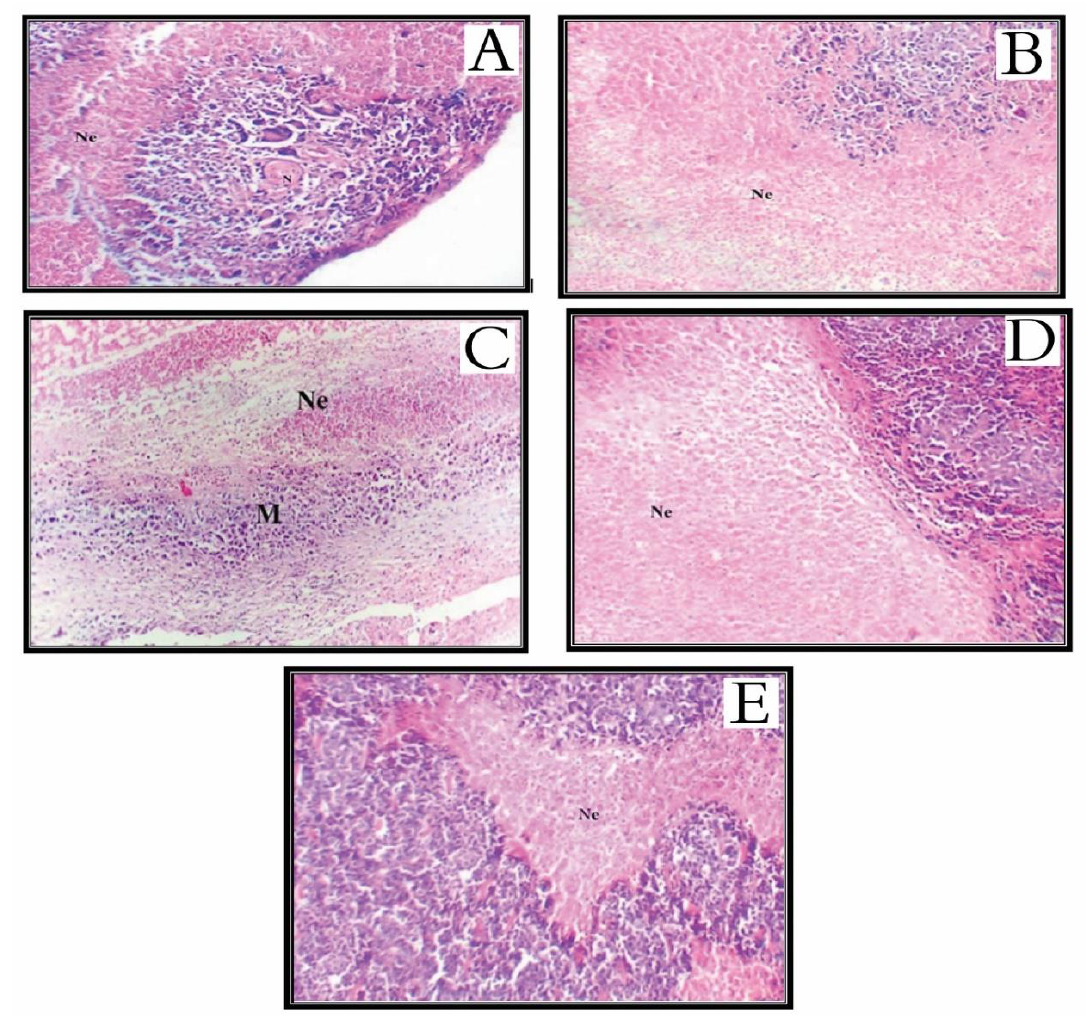
Figure 3. ( A ) Tumor section of Ehrlich positive control mouse showed an area of necrosis (Ne). ( B ) Tumor section of Ehrlich ascites carcinoma (EAC) bearing mouse treated with compound 6a displayed massive, coagulated necrosis (Ne) with minimal residual malignant cells at the upper right corner. ( C ) Tumor section of Ehrlich ascites carcinoma (EAC) bearing mouse treated with compound 6b displayed extensive necrosis (Ne) with minimal viable malignant cells. ( D ) Tumor section of Ehrlich ascites carcinoma (EAC) bearing mouse treated with compound 6c showed a massive area of coagulative necrosis (Ne) with viable tumor cells at the right side. ( E ) Tumor section of Ehrlich ascites carcinoma (EAC) bearing mouse treated with compound 6d showed massive geographic coagulative necrosis (Ne) surrounded by viable tumor cells. (H and E ×